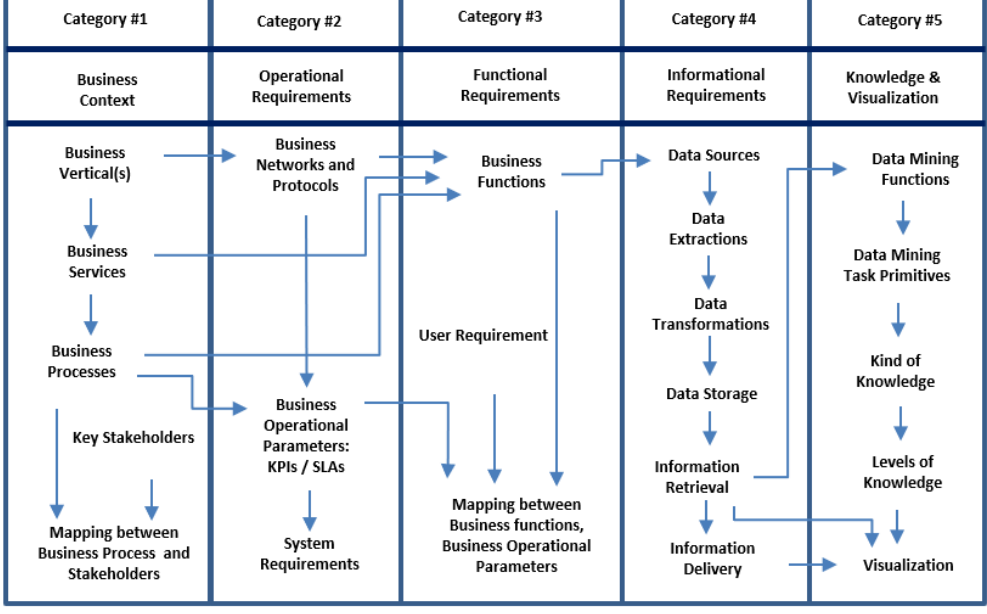
Fig. 5 Holistic view of Operational BI